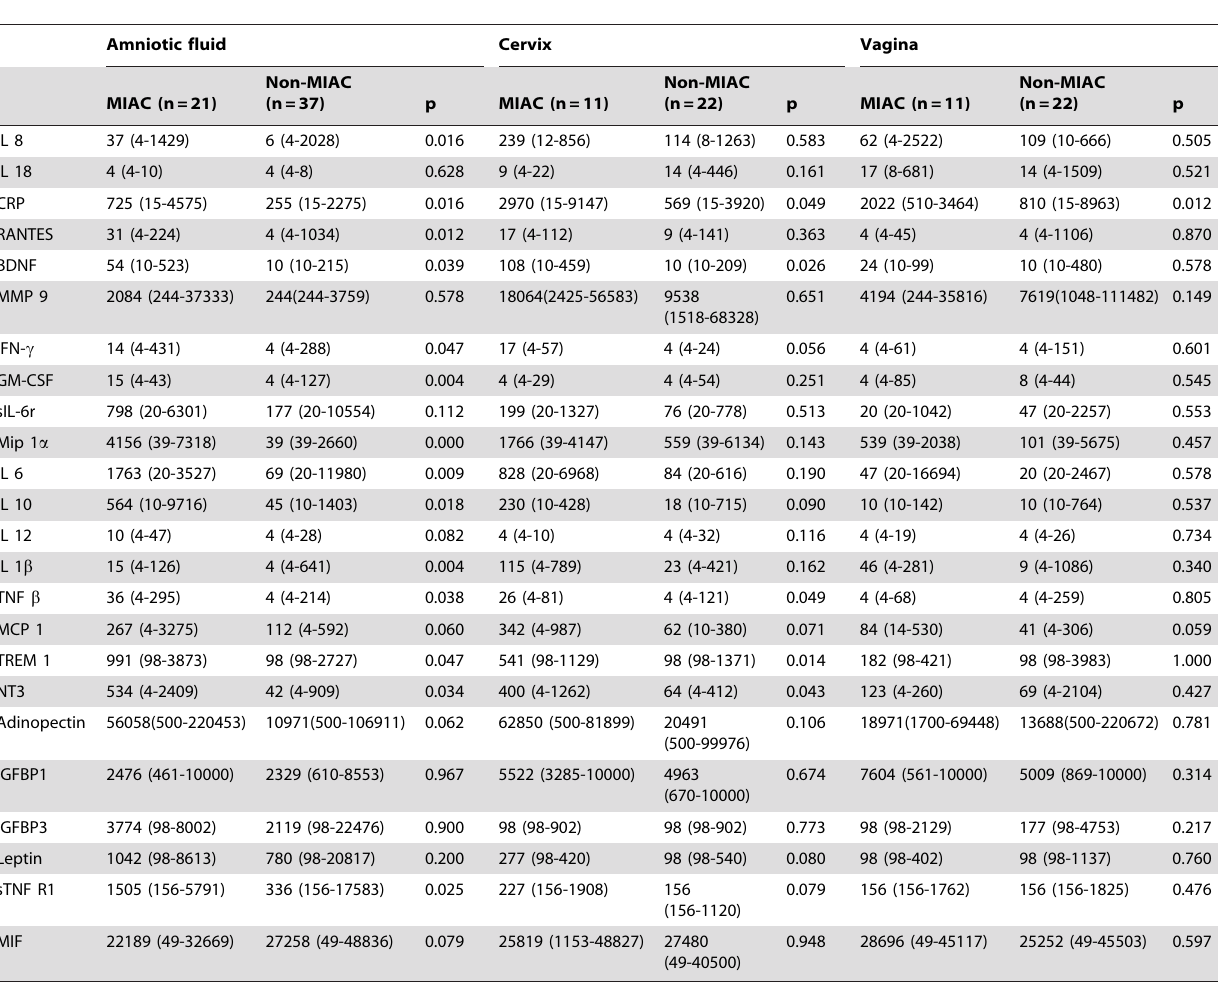
Table 2. Comparison of the levels of proteins (pg/mL) in PPROM women with and without MIAC